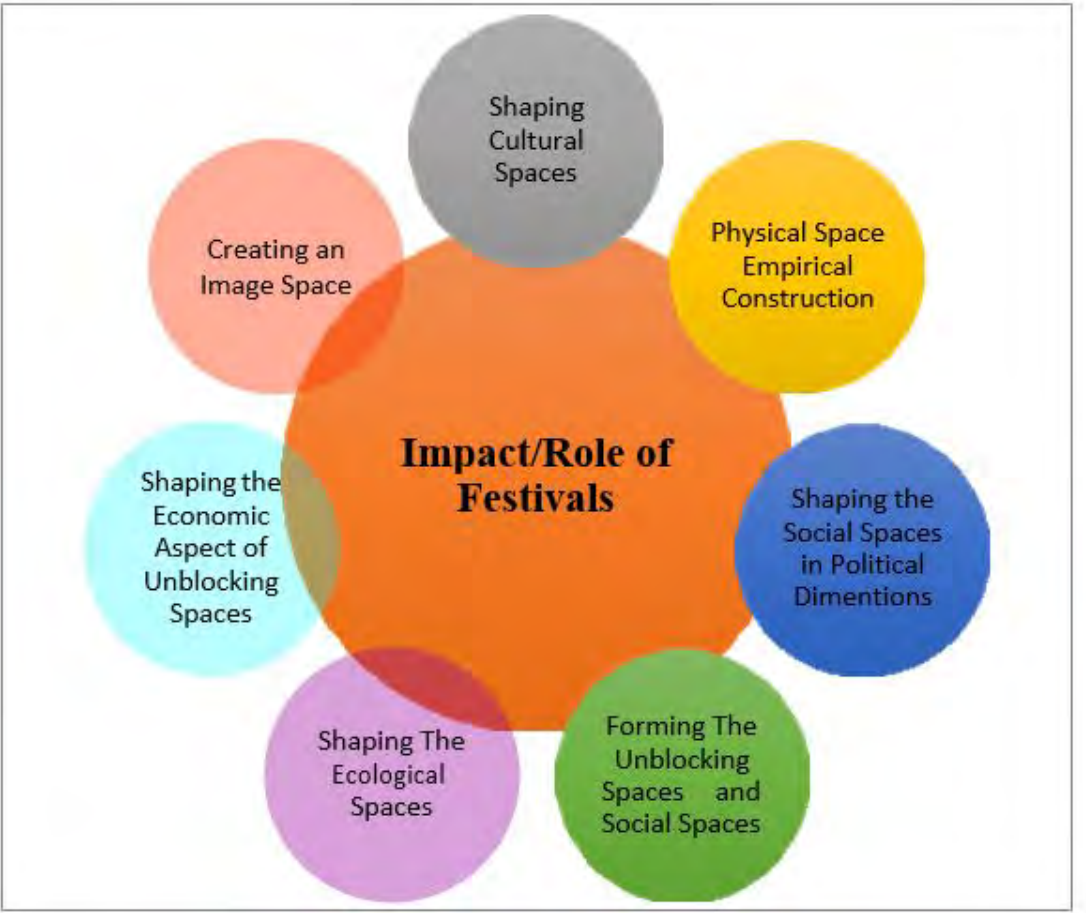
Figure 1. Shows the of festivals and their impact on